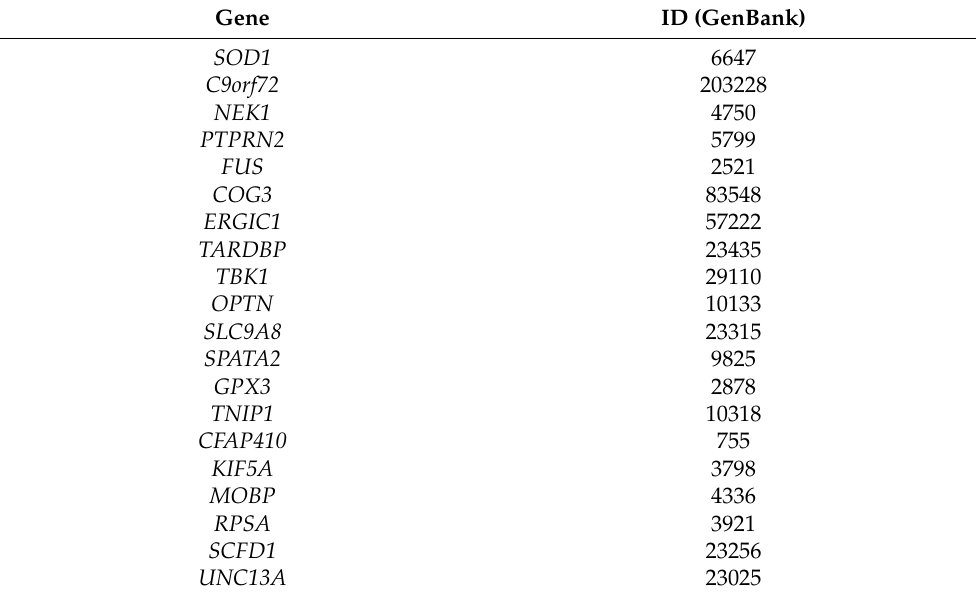
Table 1. List of the genes related to the 15 risk loci in ALS identified through the common and rare variant association analyses